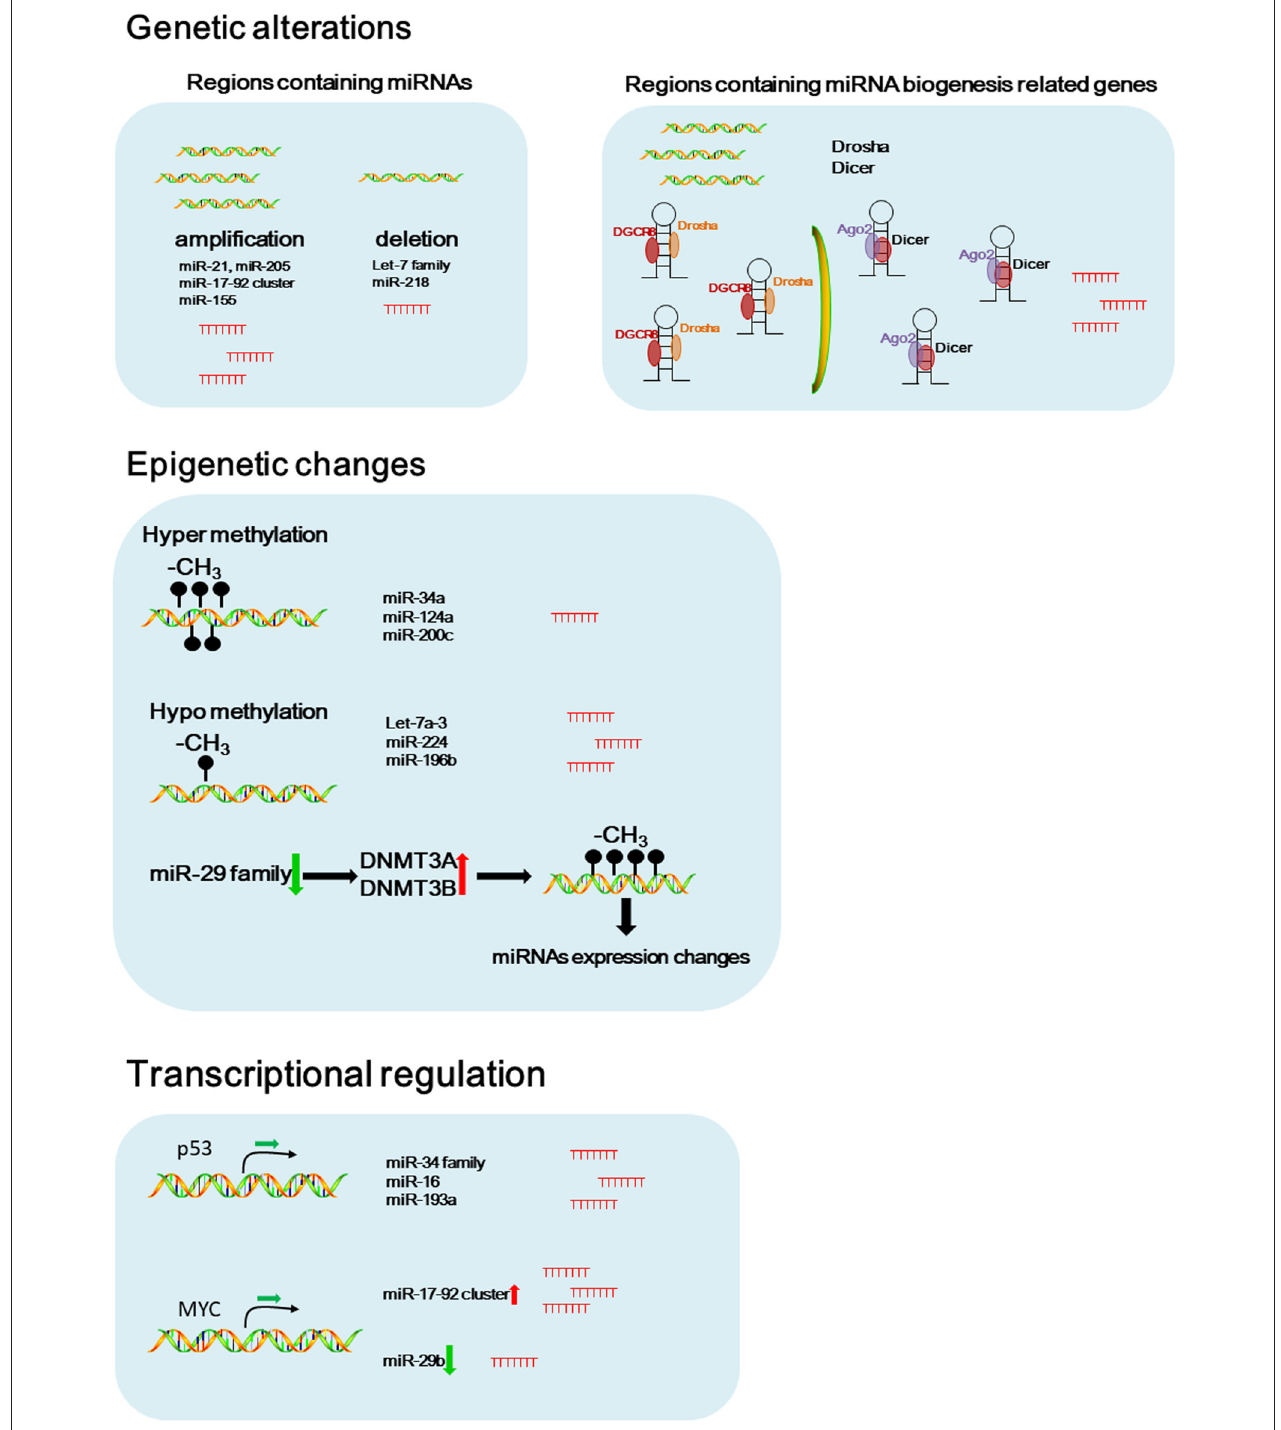
FIGURE 1 | Potential causes of dysregulated miRNAs in NSCLC. Schematic figure of the possible pathways that involved in dysregulated miRNA expressions in NSCLC. miR-222-3p promoted cell proliferation, gemcitabine resistance, migration, and invasion of NSCLC by targeting SOCS3 (Wei et al., 2017).